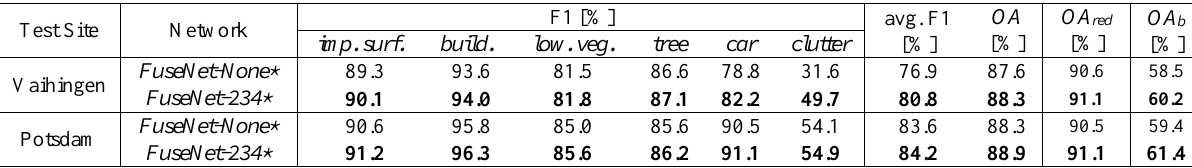
Table 3. Results of land cover classification for different network variants defined in Table 1 using the extended focal loss (eq. 4) for training. F1 : F1 score, OA : Overall Accuracy, both determined on the basis of the full reference; OA red : Overall Accuracy based on the eroded reference; OA b : Overall Accuracy for pixels in the boundary areas. Best scores per test site and metric are printed in bold